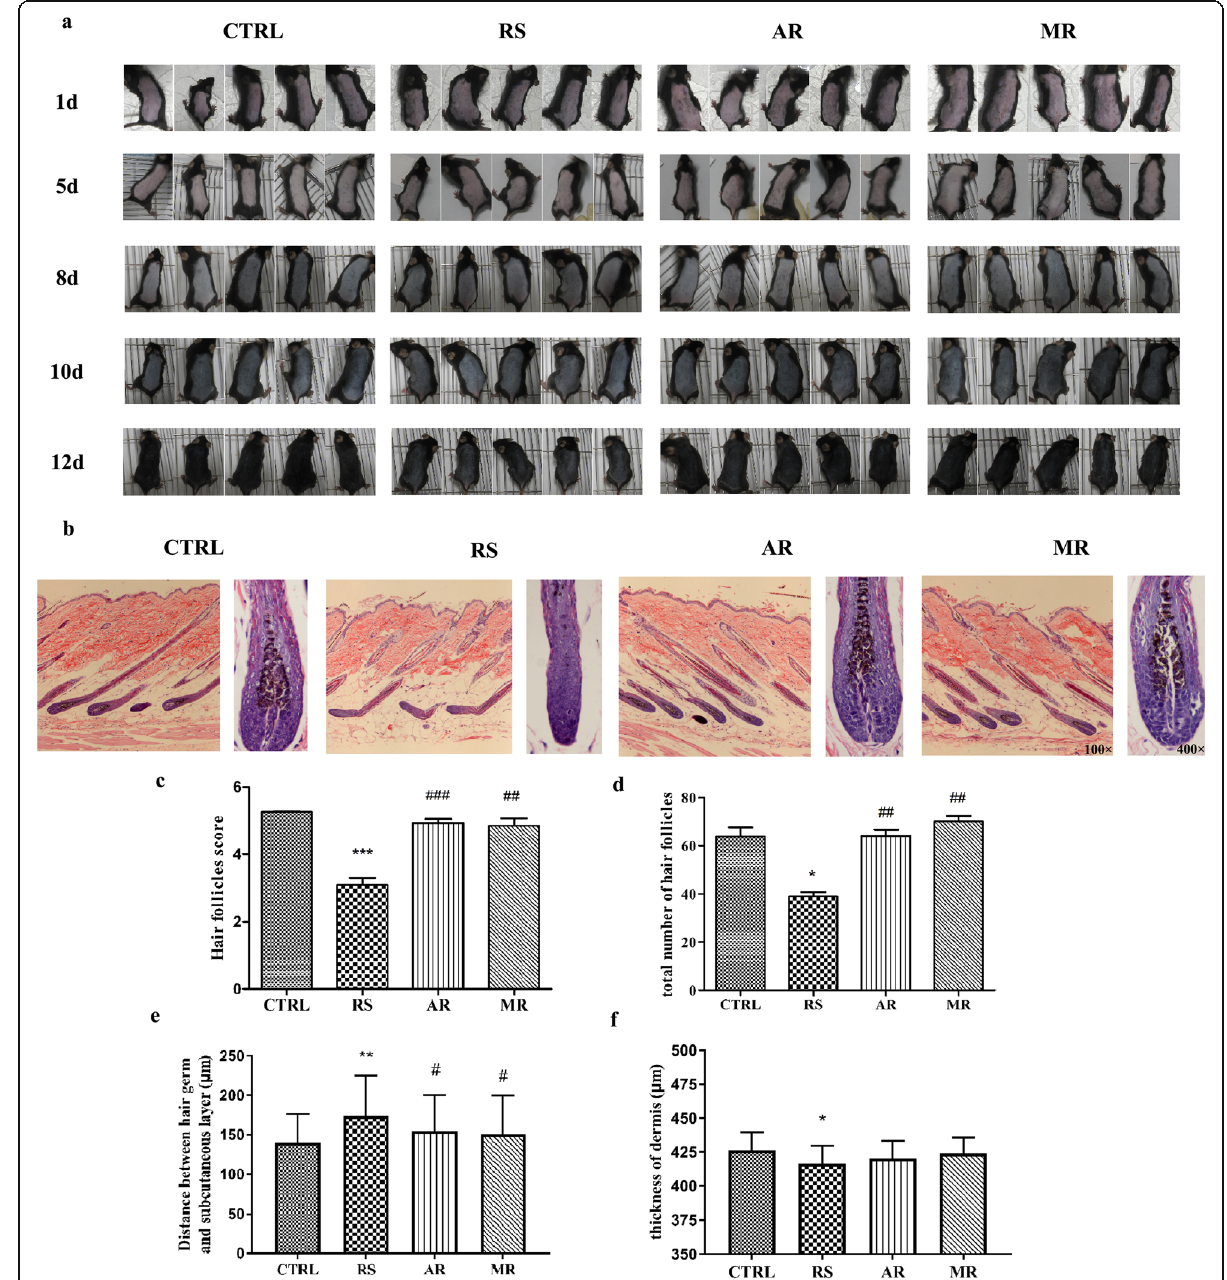
Fig. 2 Effects of AVE on hair growth in stress-induced C57BL/6 mice. a Photographs showed the color change of murine dorsal skin on day 1, 5, 8, 10 and 12 after depilation. b H & E staining of murine dorsal skin sections showed the morphological changes in hair follicles. Magnification: 100× on the left; 400× on the right. c The results of hair cycle score in each group. d The results of total number of hair follicles in each group. e Distance between the hair germ and the subcutaneous layer in each group. f Thickness of dermis in each group. Data are presented as mean ± S.E.M, n = 3 – 5 in each group. * p < 0.05, ** p < 0.01, *** p < 0.001 compared with CTRL group; ## p < 0.01, ### p < 0.001 compared with RS